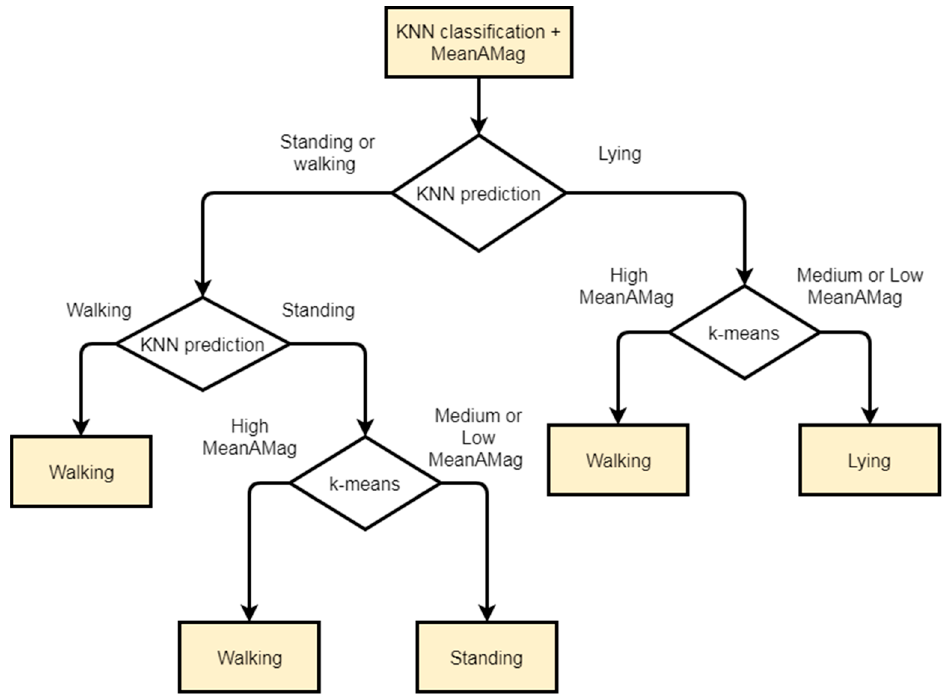
Figure 5. Decision tree rules for the combination of both KNN and k-means algorithms.